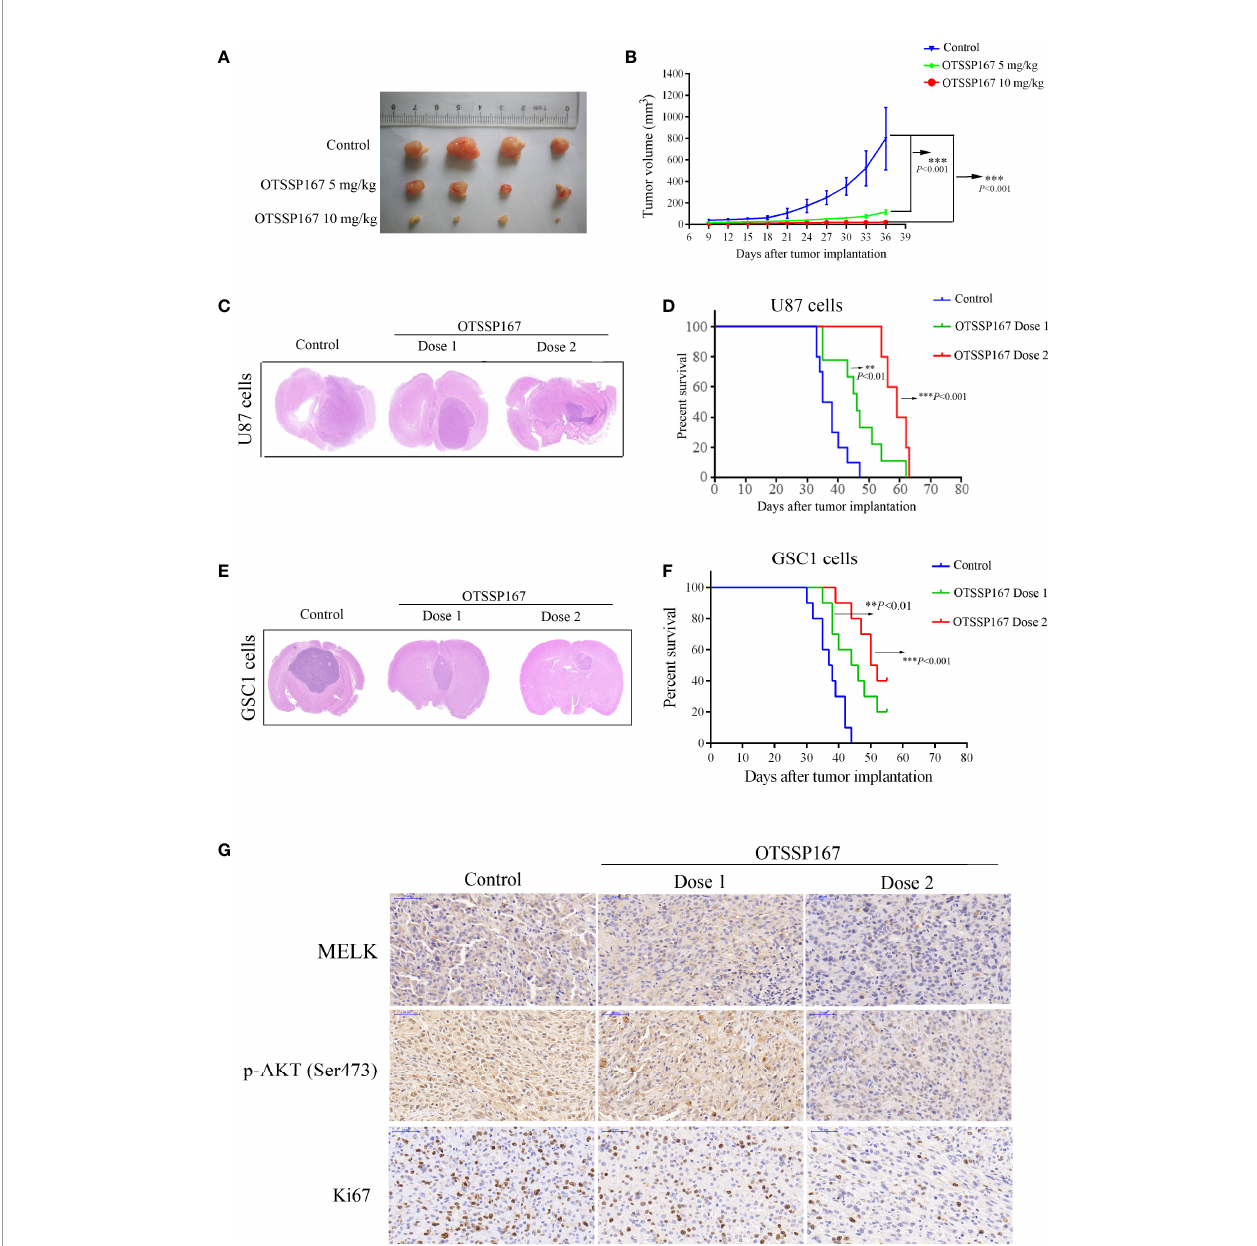
FIGURE 6 | OTSSP167 suppresses tumor growth in vivo and increases the survival of animals bearing intracranial GBM. (A) Representative tumors isolated from the control and OTSSP167-treated groups of subcutaneous tumor model. (B) The mean tumor volumes were assessed at the indicated numbers of days after tumor implantation. (C) Mice bearing U87 xenograft tumor were treated with OTSSP167 (5 m L of 1 m M (dose 1) or 2 m M (dose 2) OTSSP167 in 1% DMSO in PBS per mouse) or vehicle control by intratumoral injection once a week for 4 weeks. Representative images of H&E staining of whole brain sections from control group and OTSSP167 treatment group. (D) Kaplan-Meier survival curves of mice implanted with U87 cells (n=10, ** P < 0.01, *** P < 0.001). In vivo animal studies to investigate the effect of OTSSP167 administration on the growth of GSC-driven tumor. Tumor size (E) and survival time (F) were analyzed by using the above same treatment. The survival time of tumor-bearing mice was counted by the end of the 55th day after tumor implantation. (G) Representative IHC staining images of p-AKT(Ser473) and Ki67 expression in U87 xenograft tumor of control and OTSSP167 treatment groups. Sections were counterstained with results indicate that AKT may be one of the direct or indirect target proteins of MELK in GBM, and the inhibitory effect of OTSSP167 on GBM proliferation is dependent on blocking the AKT pathway.